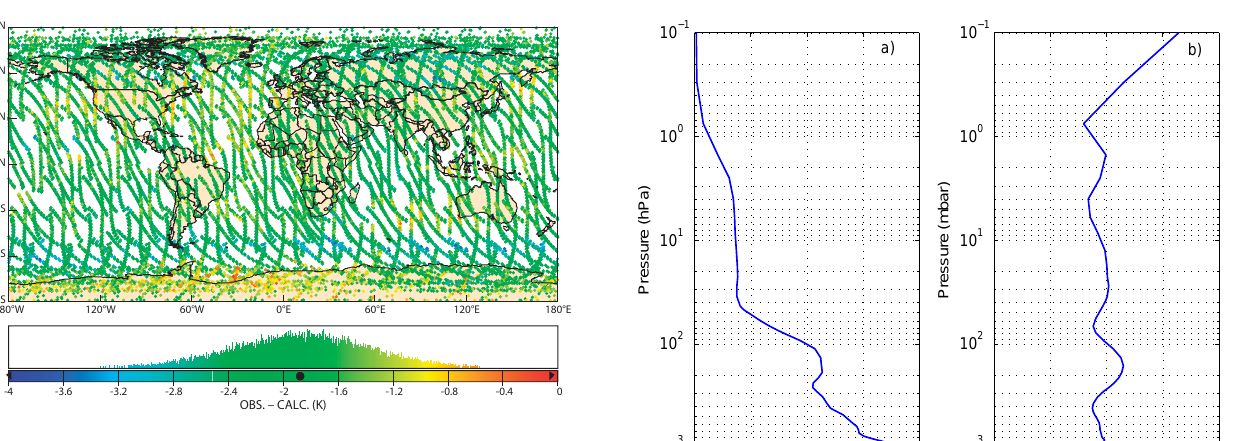
Fig. 14. Global distribution of the difference between observations and calculations for IASI channel 92 (667.75cm − 1 ) for one day (4 April 2008) of thinned IASI data. Results are expressed in units of equivalent brightness temperature (K). Calculations have been performed using LBLRTM.